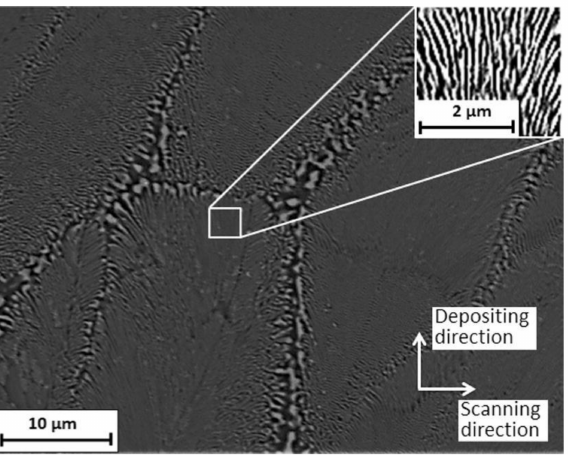
Figure 7. Microstructure of the deposited alumina + zirconium dioxide ceramic [1]; with permission from